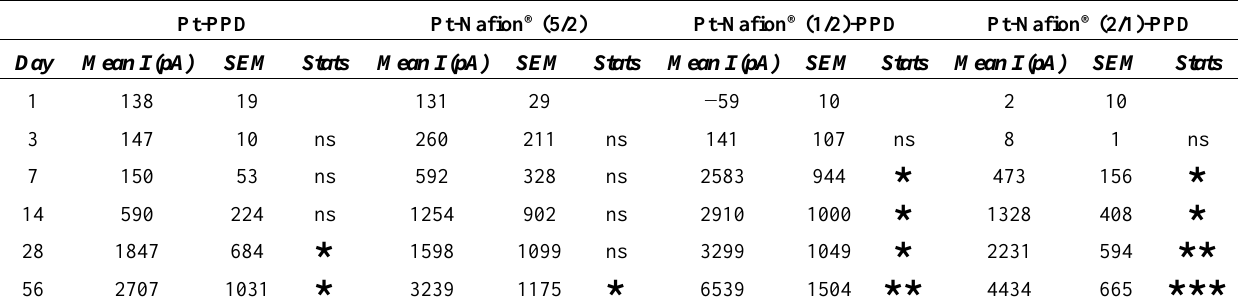
Table 1. Shelf-life data for various platinum (Pt)-modified electrodes. Electrodes calibrated on day 1, 3, 7, 14, 28, and 56. Data represents maximum current recorded at 1000 μM ascorbic acid (AA) for each electrode type ( n = 4). “  ” denotes level of significance against day 1. “ns” denotes no significant